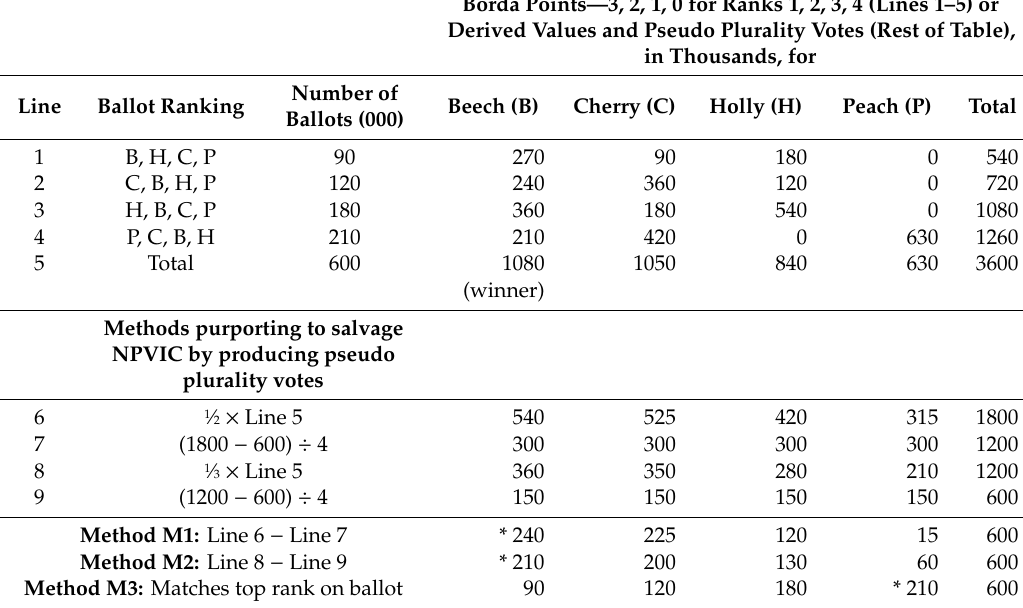
Table 7. Details for Borda count for Montana (2024 election, Scenario 3). Borda Points—3, 2, 1, 0 for Ranks 1, 2, 3, 4 (Lines 1–5) or Derived Values and Pseudo Plurality Votes (Rest of Table), in Thousands, for